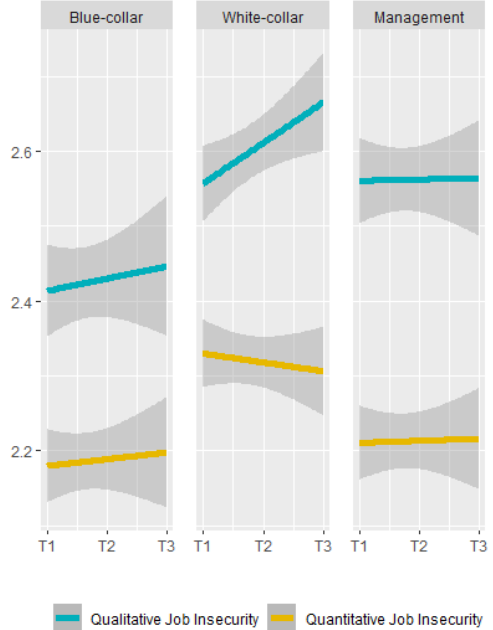
Figure A6. Occupational position.